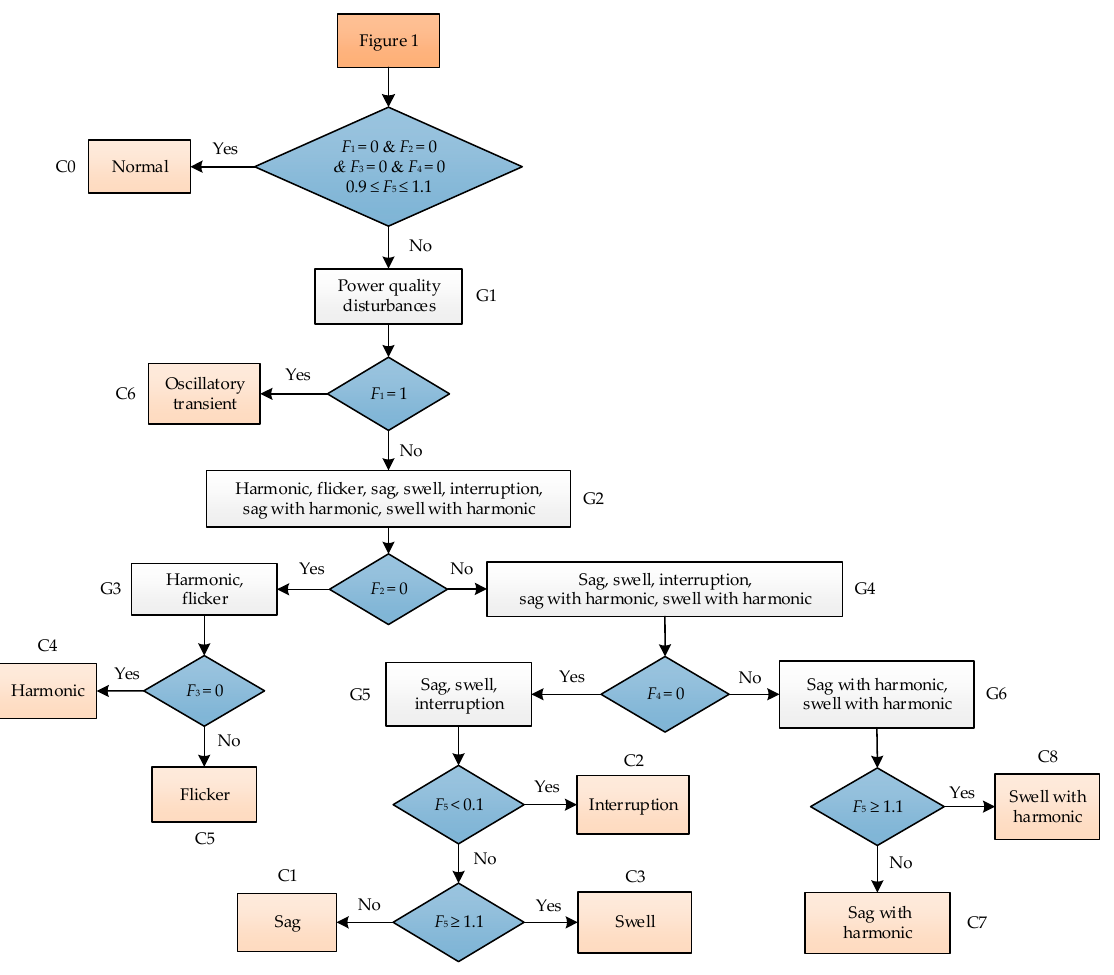
Figure 11. The proposed algorithm for detecting and classifying power quality (PQ) disturbances. Table 1. PQ disturbance values.